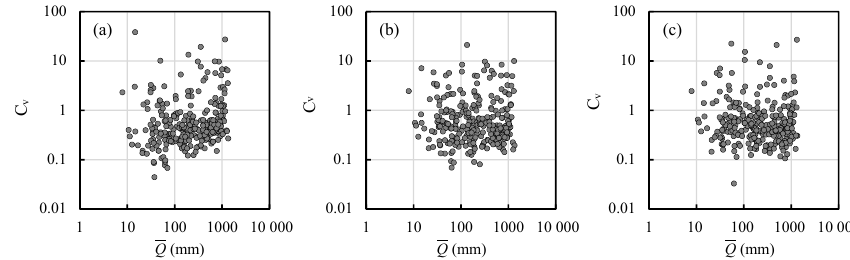
Figure 12. C v values of projected future trends (cid:49)Q e under (a) RCP2.6, (b) RCP4.5, and (c) RCP8.5